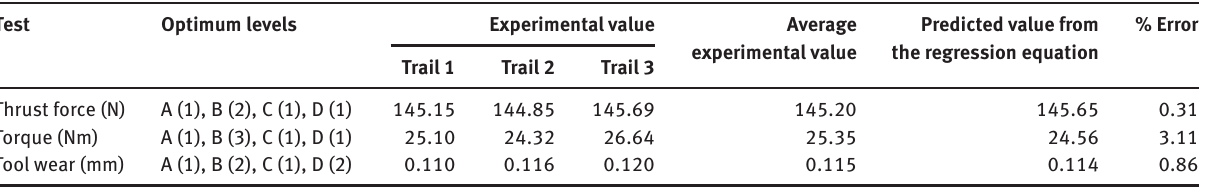
Table 11: Results of the confirmation